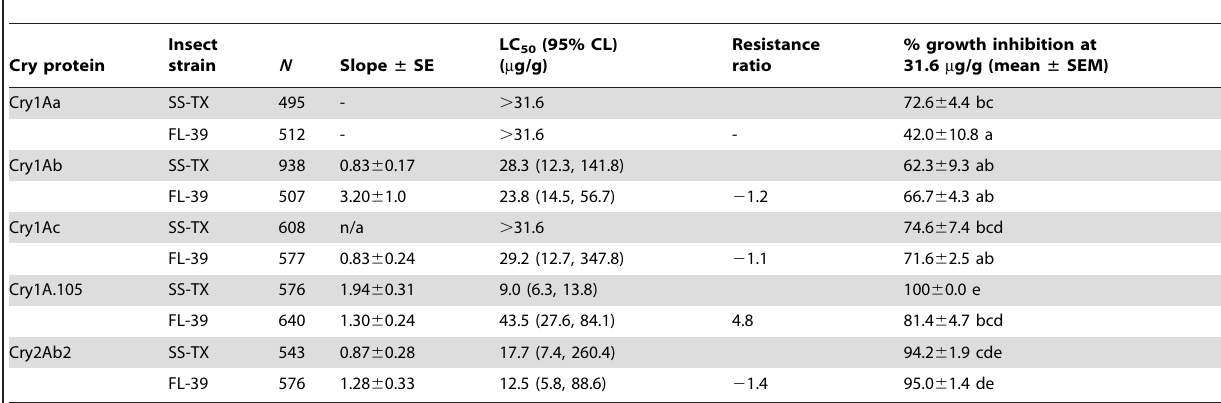
Table 3. Median lethal concentrations (LC 50 ) and 95% confidence limits (CL) based on larval mortality of Cry1F-susceptible (SS-TX) and -resistant (FL-39) strains of Spodoptera frugiperda to five individual Cry